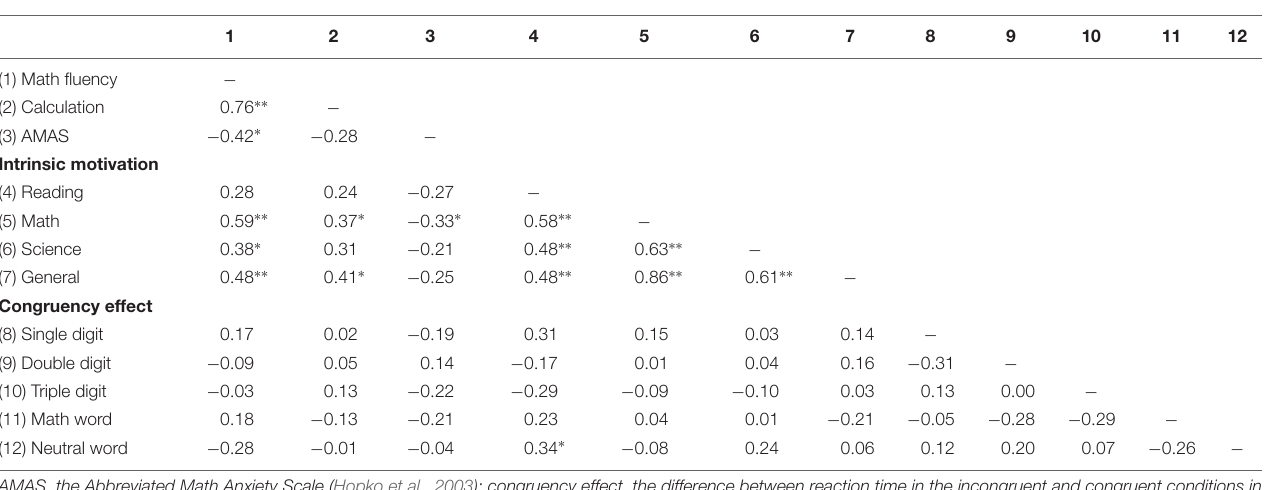
TABLE 2 | Pearson correlation matrix of children’s variables.